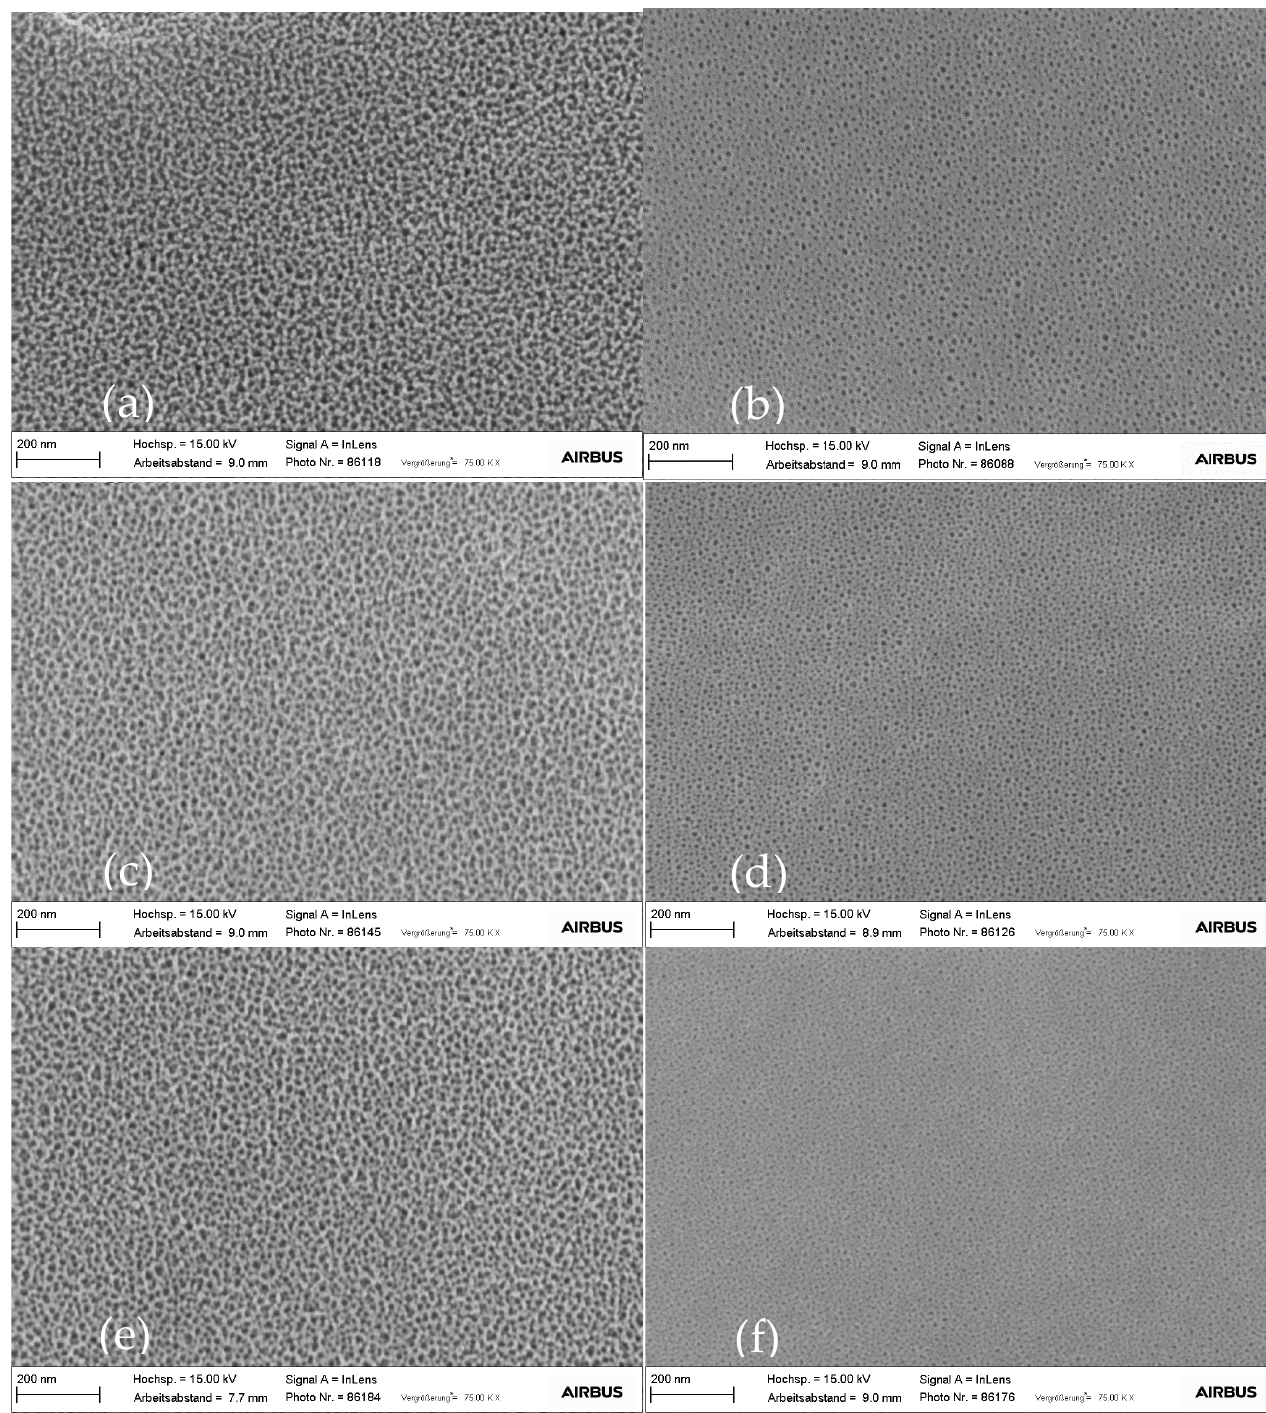
Figure 4. FE-SEM micrographs in top view of ( a ) SAA 14 V 45 °C; ( b ) SAA 20 V 37 °C; ( c ) TSA 14 V 55 °C; ( d ) TSA 20 V 37 °C; ( e ) T + SA 14 V 55 °C; ( f ) T + SA 20 V 37 °C.